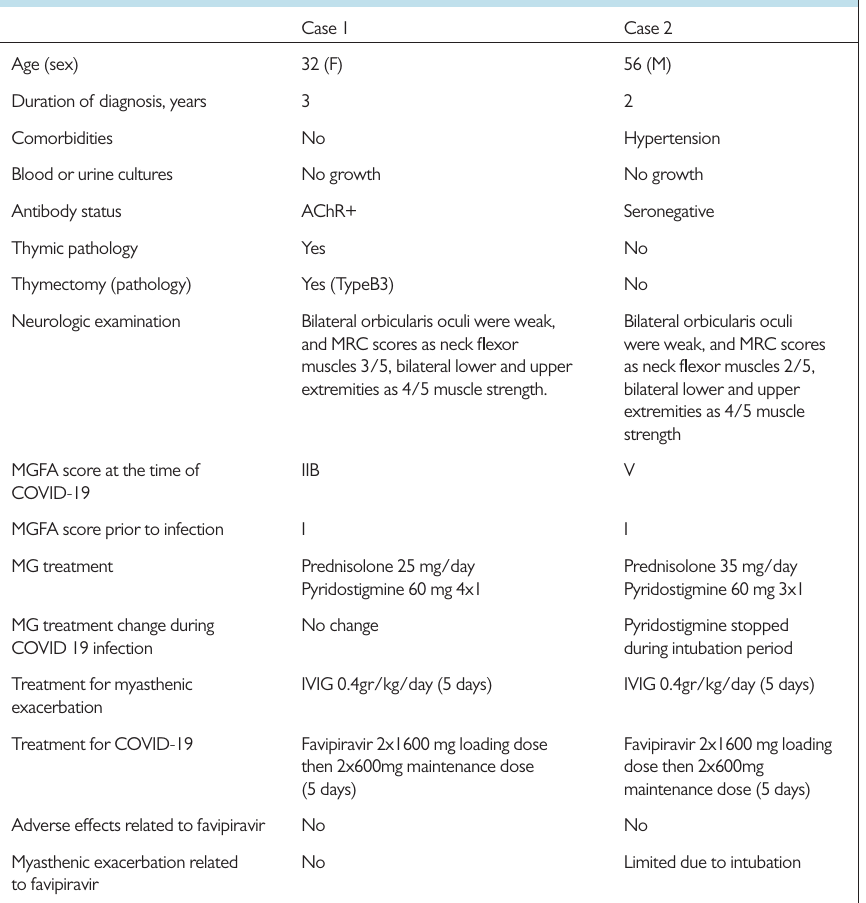
Table 1. Patient